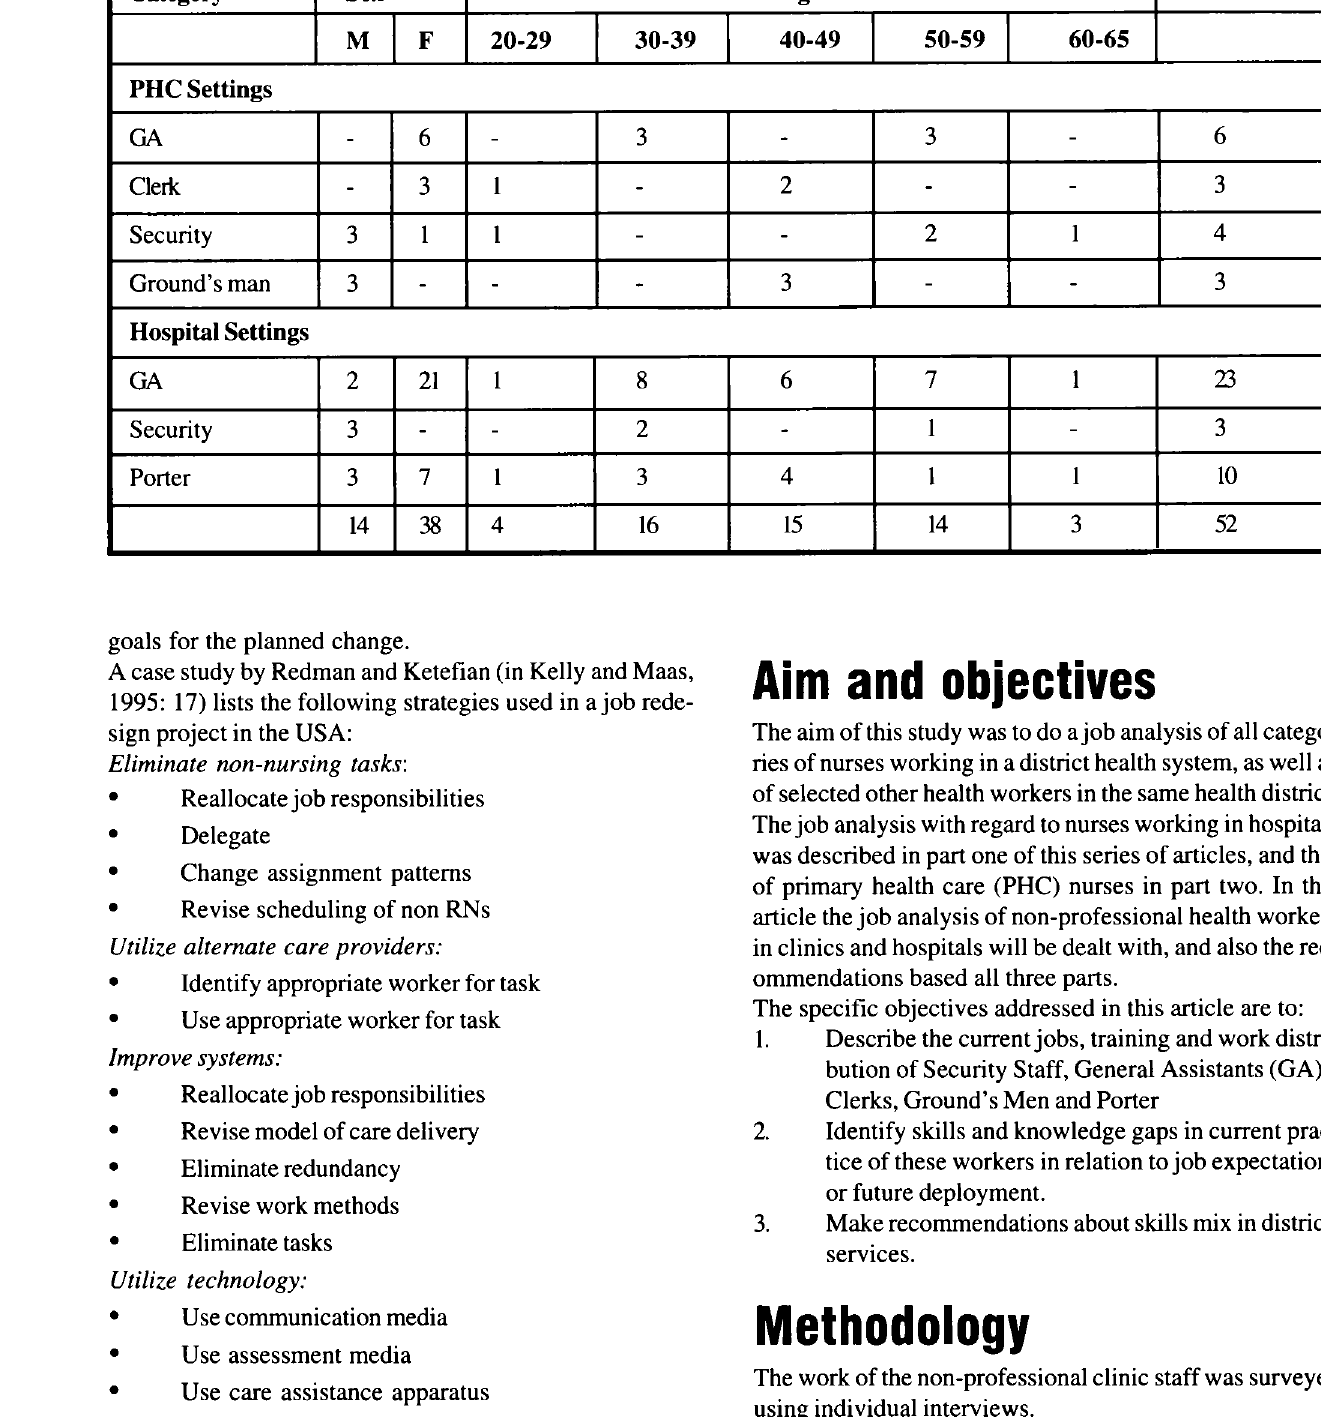
Table 3.1 Health workers interviewed according to age and sex. Category